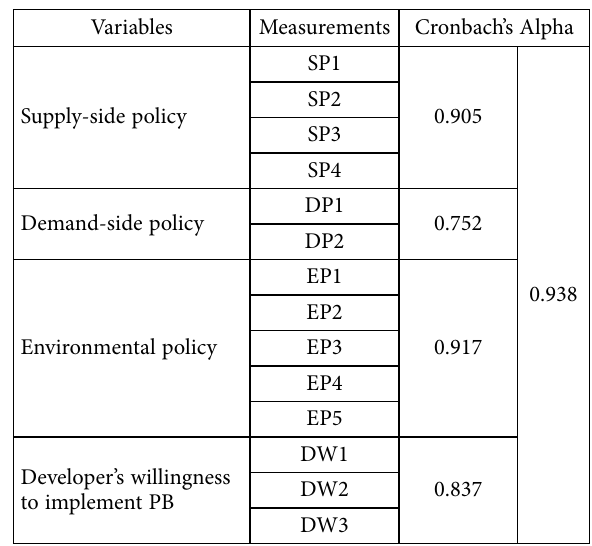
Table 6. Reliability of variables